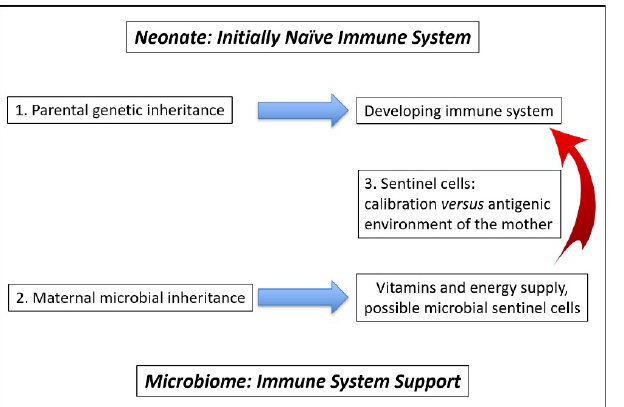
Figure 1. The Role of the Foetal Microbiome in Immune System Education. Box 1 . The foetus develops according to its parental genetic inheritance, but initially with a naïve immune system. Box 2 . The microbiome of the neonate is provided by its microbial inheritance from the mother. Box 3